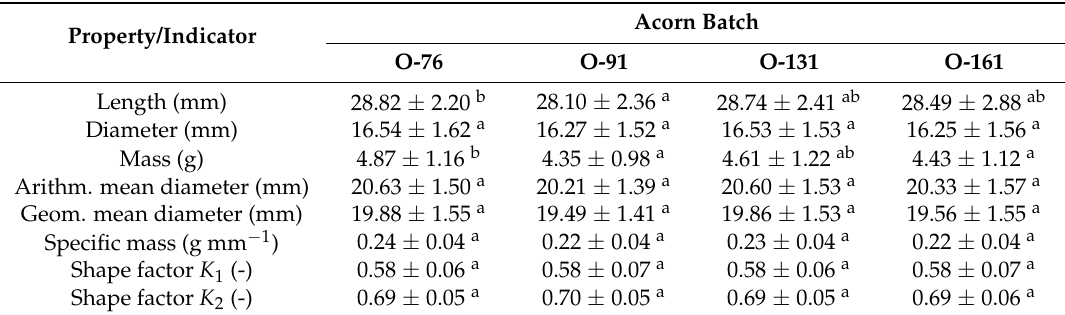
Table 1. Statistical distribution of the physical properties (mean value ± standard deviation) of acorns and significant differences between batches.